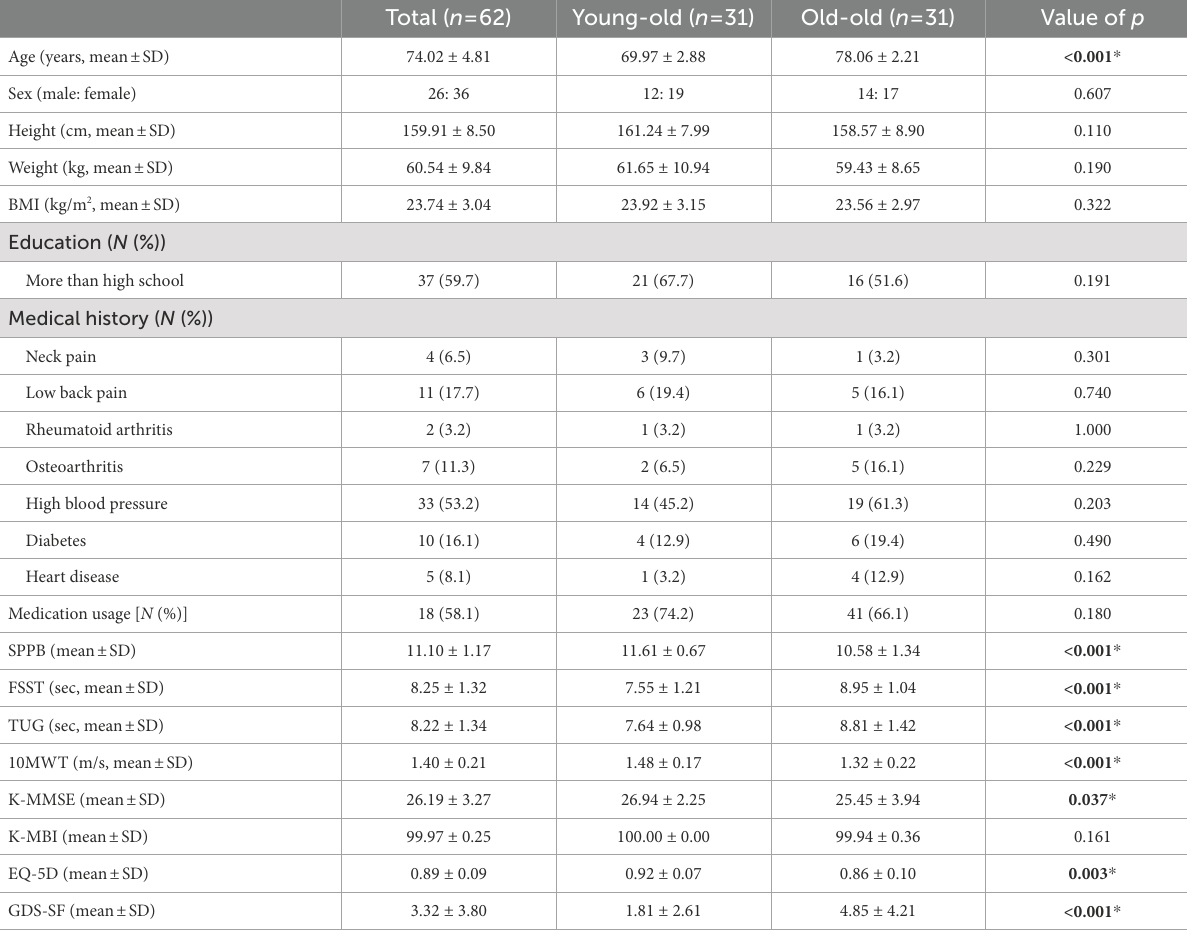
TABLE 1 Demographic characteristics and functional differences between the young-old and old-old